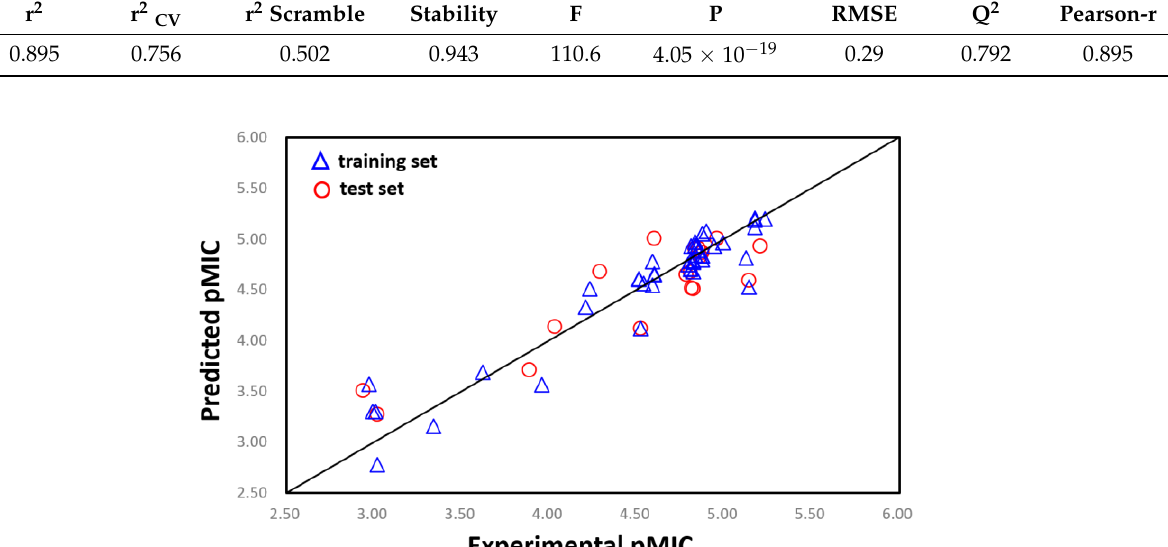
Table 3. Statistical parameters of the selected 3D QSAR model (PLS factor 3).